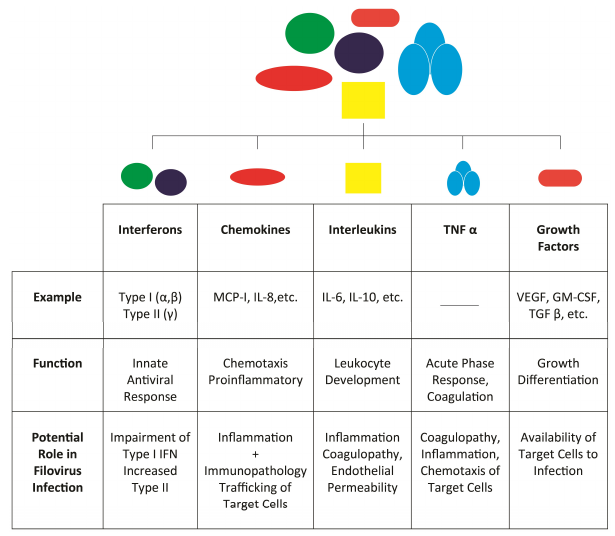
Figure 1. Cytokine families and their functions.